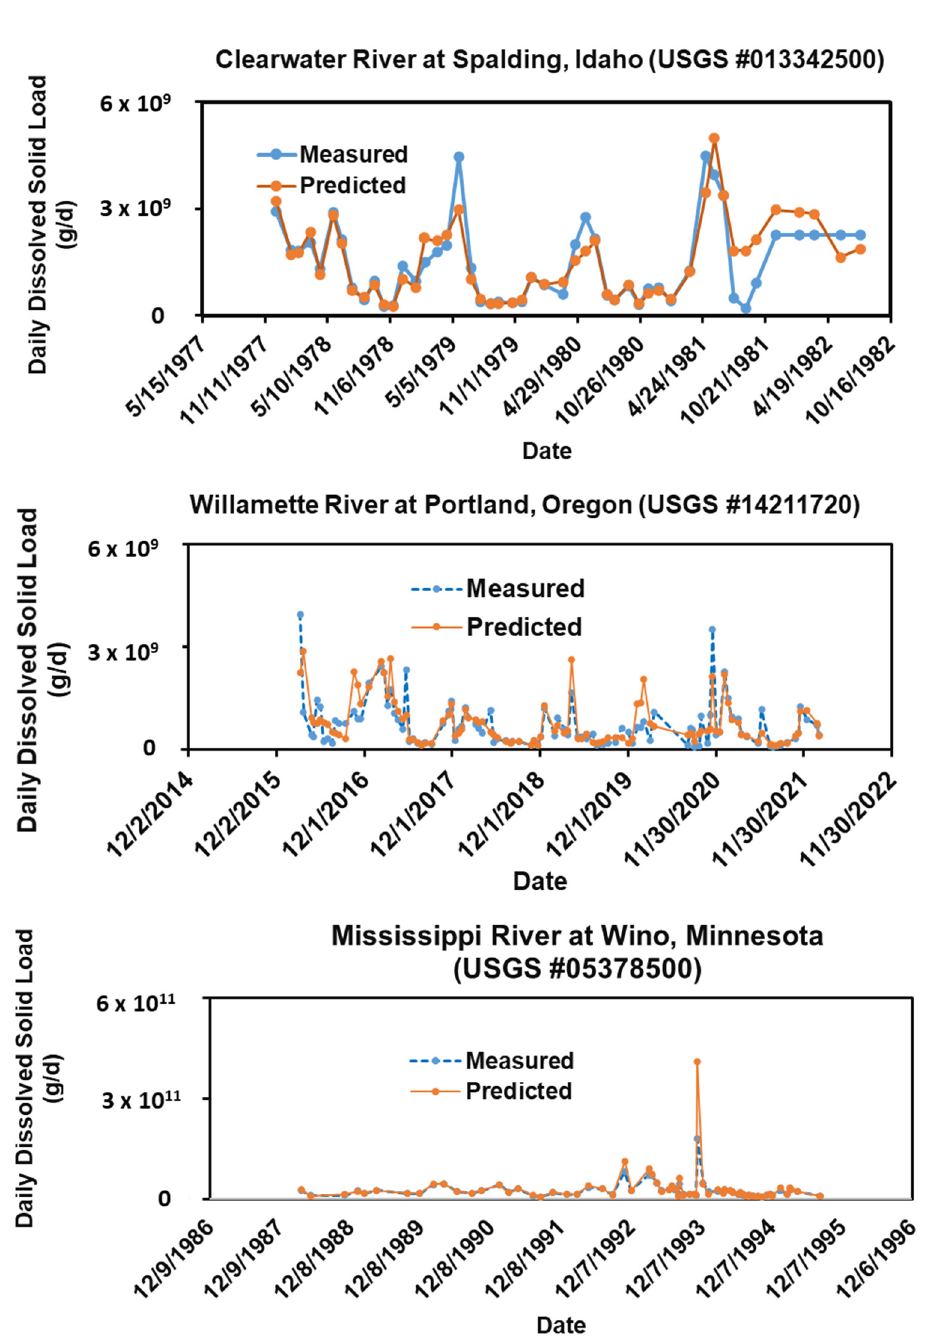
Figure 5. Comparisons of the daily sediment loads between the method predictions and the field measurements for Stations #013342500, #14211720, and #05378500. measurements for Stations #013342500, #14211720, and